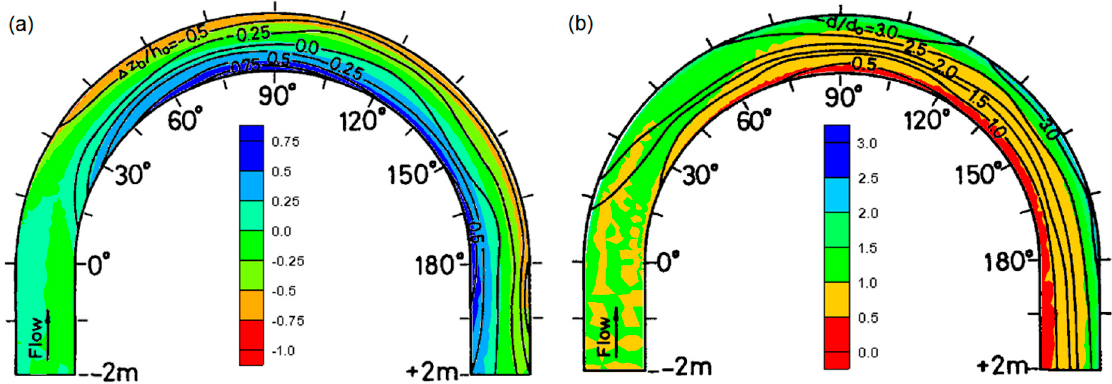
Figure 9. Measured (isolines) and TELEMAC calculated (colored) contours: ( a ) bed evolutions normalized by the initial water depth ( h 0 = 0.0544 m); ( b ) median sediment size normalized by the initial median